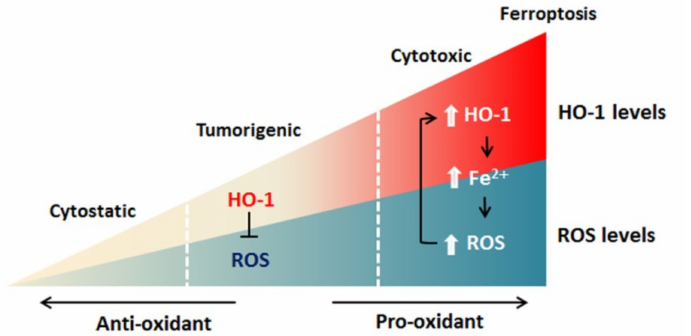
Figure 3. Model of HO-1-mediated ferroptosis. HO-1 exerts a cytoprotective effect by scavenging ROS during moderate activation. By contrast, excessive activation of HO-1 increases labile Fe 2+ , leading to ROS overload and death of cancer